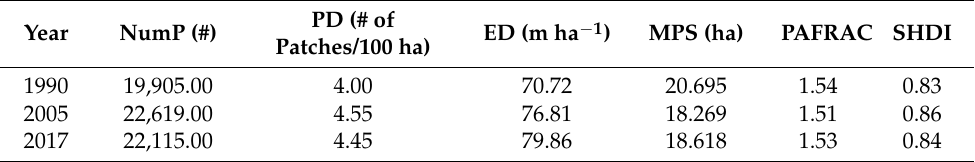
Table 5. Values of the metrics at the landscape level for the land use/land cover of 1990, 2005 and